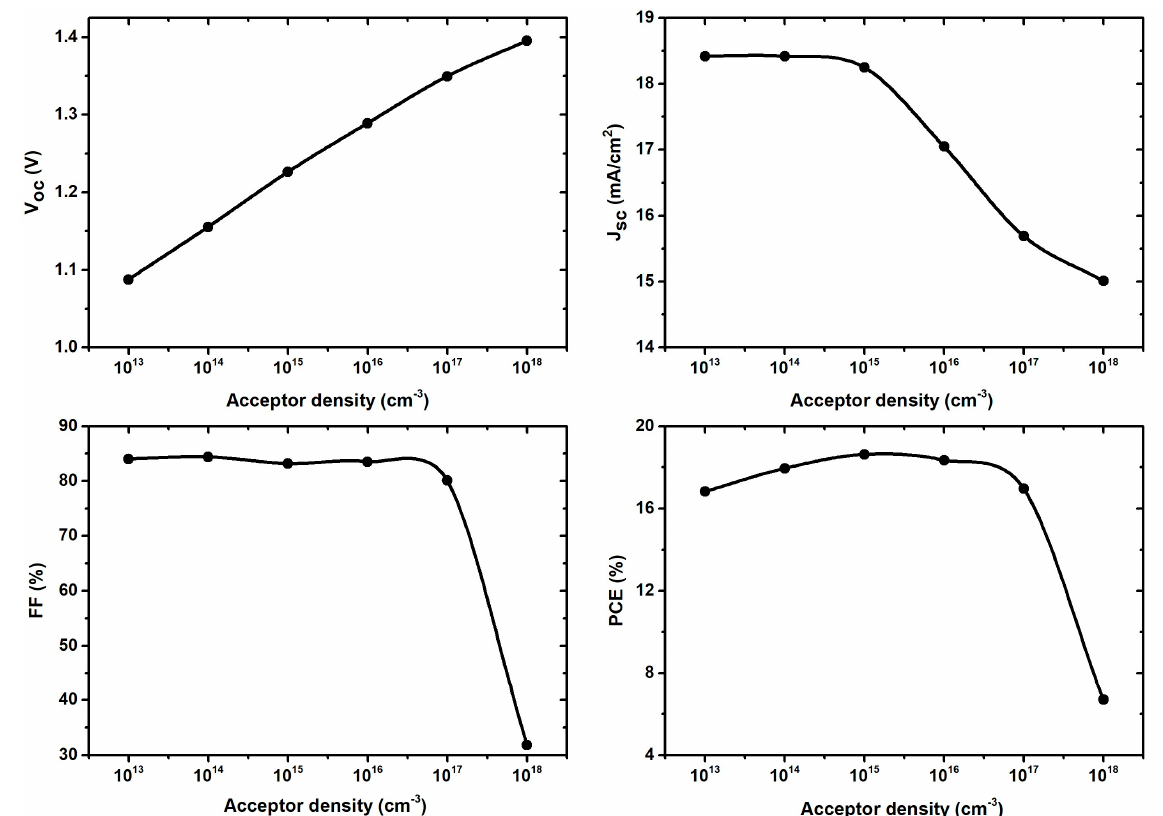
Figure 8. Variation in PV parameters by varying the C 2 N doping concentration.